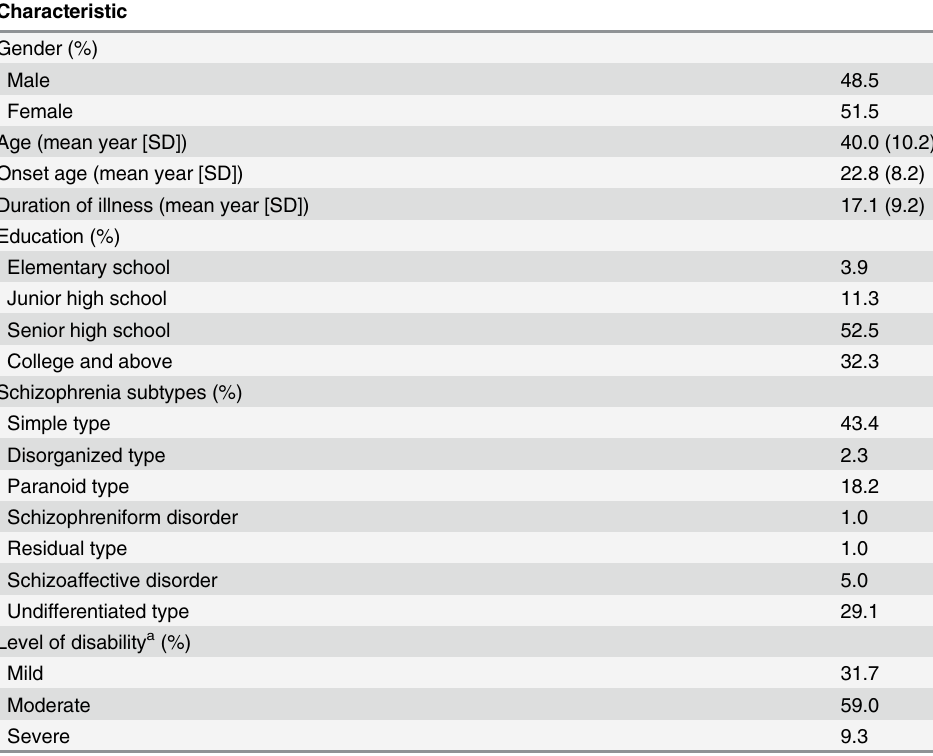
Table 1. Characteristics the patients with schizophrenia (n =